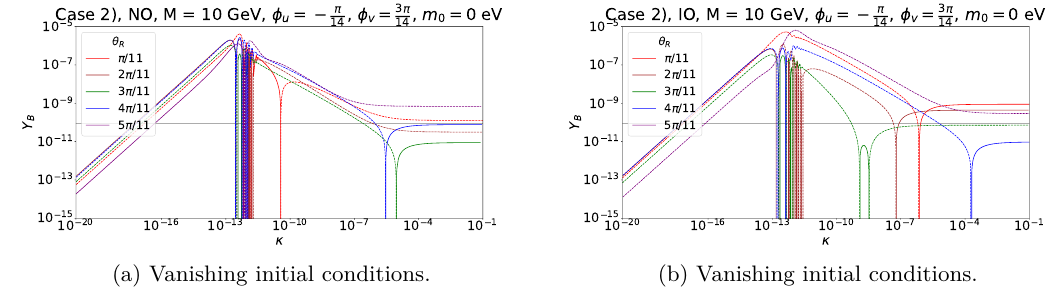
(b) Vanishing initial conditions. Figure 32 . Case 2) Y B as function of κ for a Majorana mass M = 10 GeV. Light neutrino